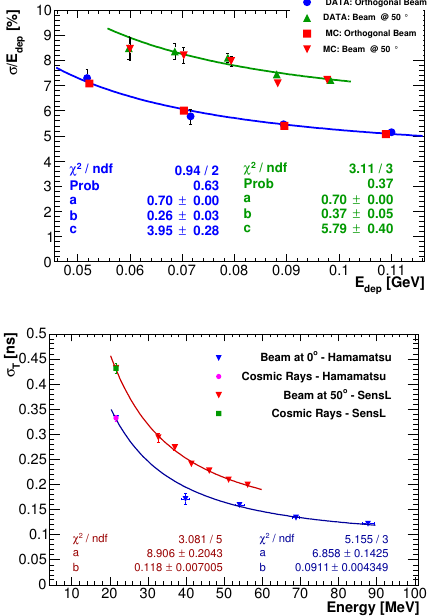
Figure 10. (Top) energy resolution as a function of beam energy for straight electrons (blue points) and electrons impinging at 50 ◦ (green points). Simulation curves are overimposed. (Bottom) timing resolution as a function of beam energy for straight elec- trons (blue points) and electrons impinging at 50 ◦ (red